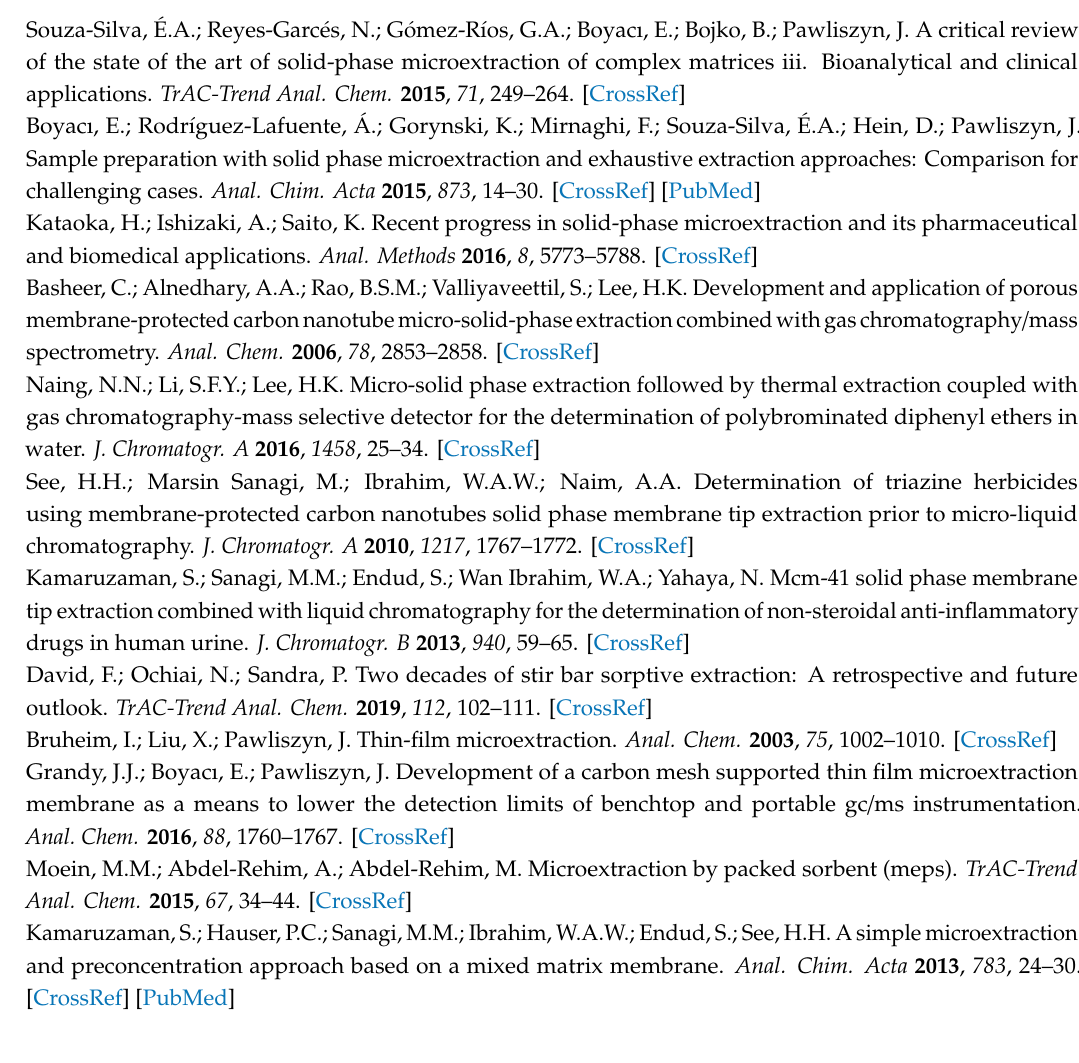
Figure S1: E ff ect of sample pH on peak responses using mixed matrix membrane tip microextraction, Figure S2: E ff ectofadditionofsaltonpeakresponsesusingmixedmatrixmembranetipmicroextraction, TableS1: Comparison of the current work with other previous methods for analysis of